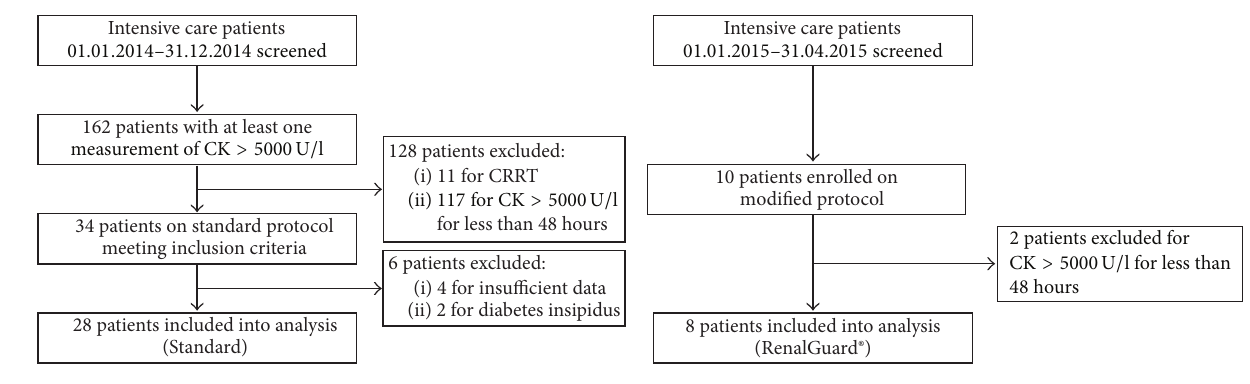
Figure 1: Recruitment flow chart.